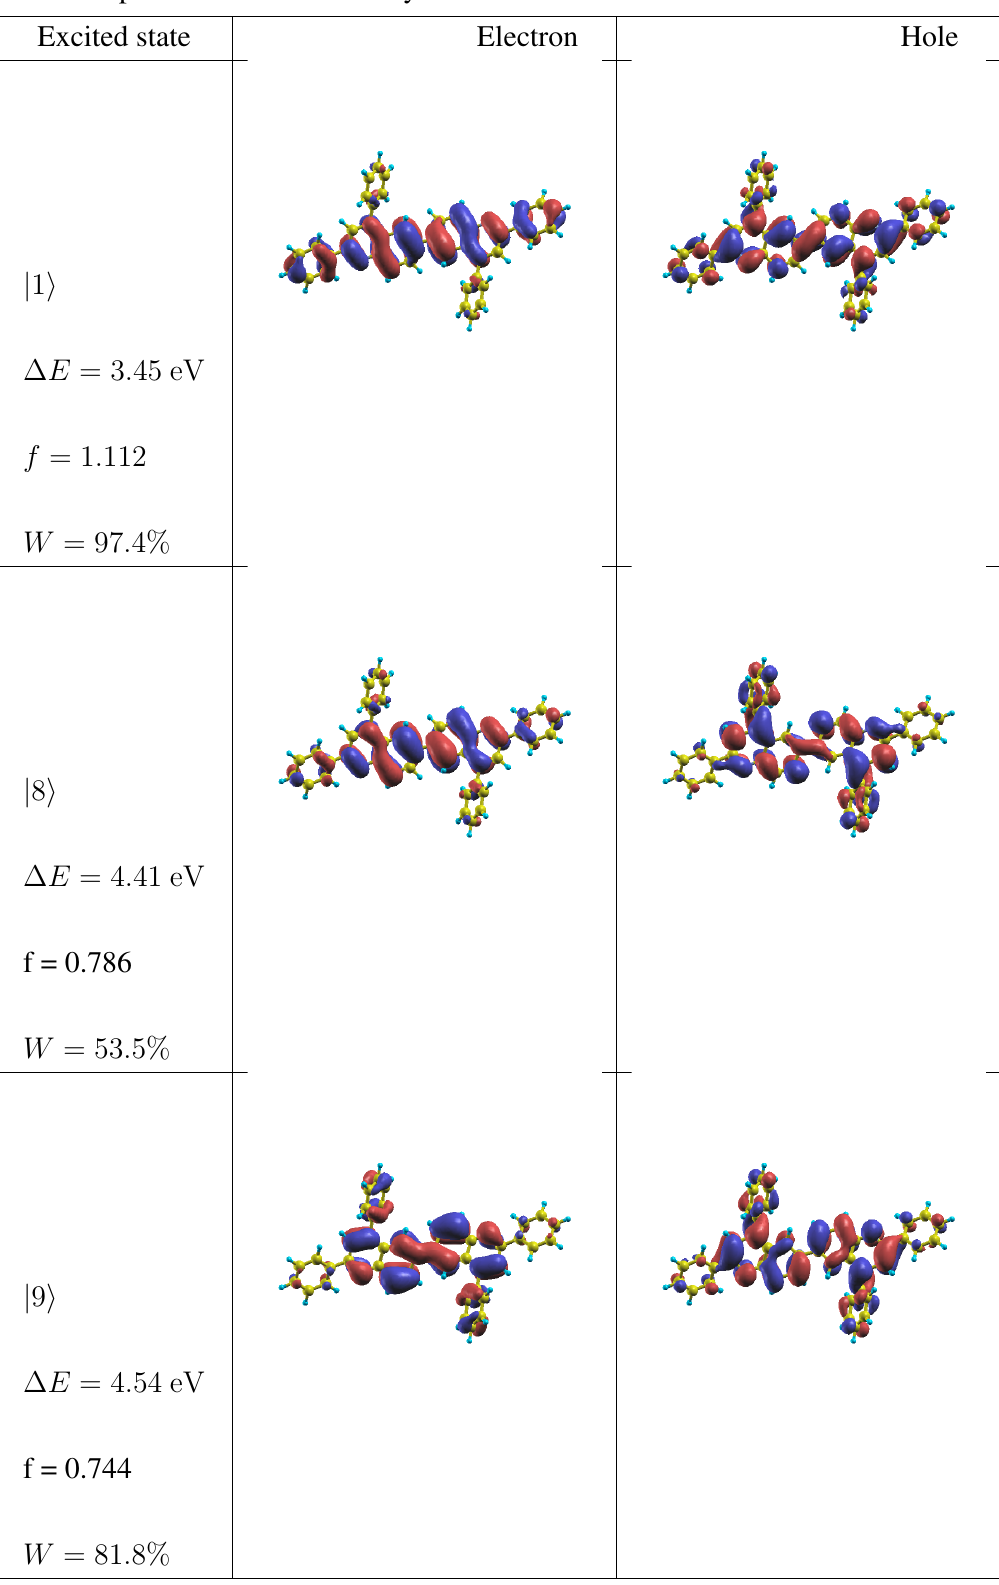
Table 17. TDDFT natural transition orbital analysis for the three excited states with the largest oscillator strengths in B1PPQ in gas phase. ∆ E is the excitation energy, f is the corresponding oscillator strength, and W is the weight of the plotted orbital in the respective transition density